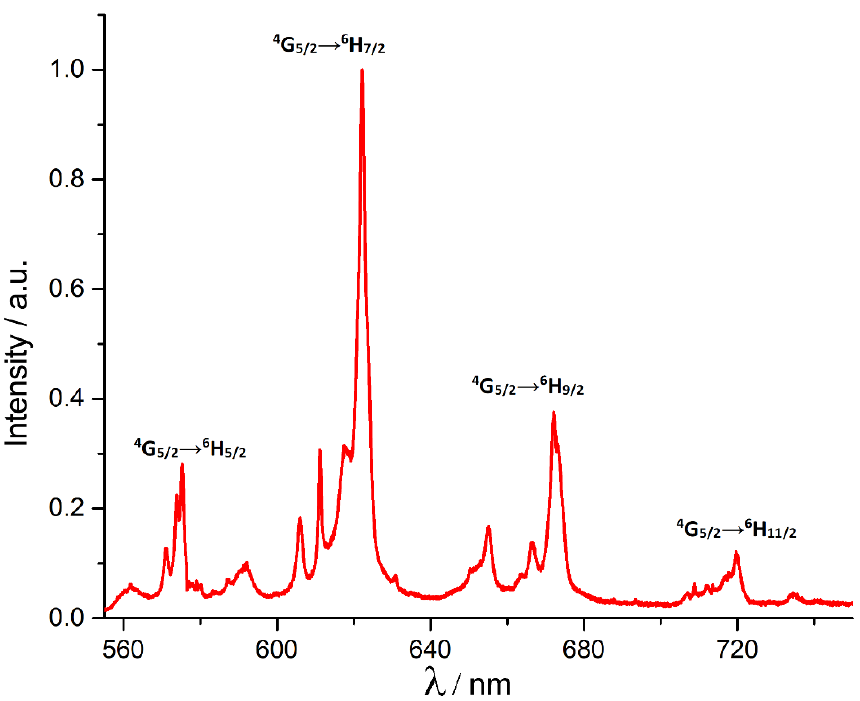
Figure 3. Luminescence spectra of (ZrO 2 ) 0.96 (Sm 2 O 3 ) 0.04 crystals upon excitation to the 4 G 5/2 level of Sm 3+ ions, λ ex = 532 nm.